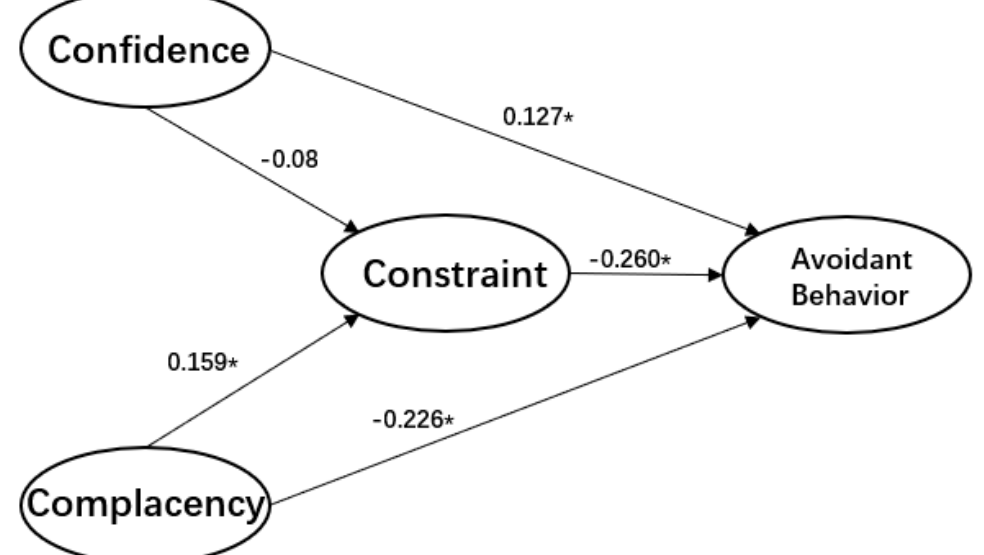
Figure 2. Model estimation of the 3C-avoidant behavior model (Israel), * p < 0.05.